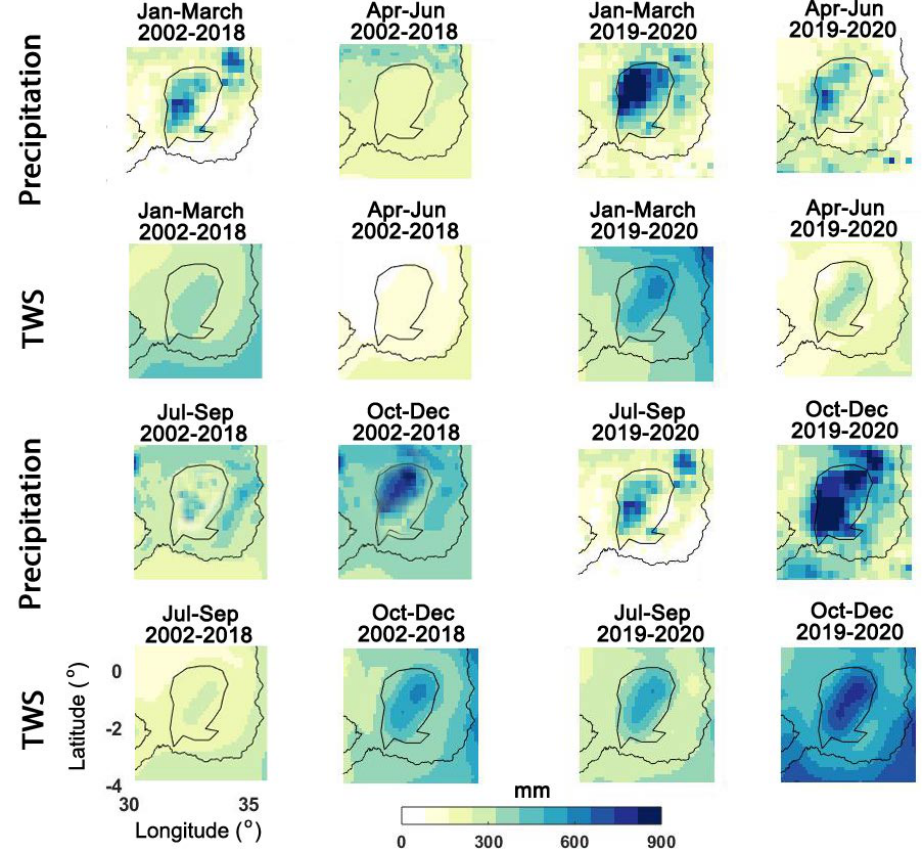
Figure 6. Average TWS and precipitation maps for various periods within the LV region.